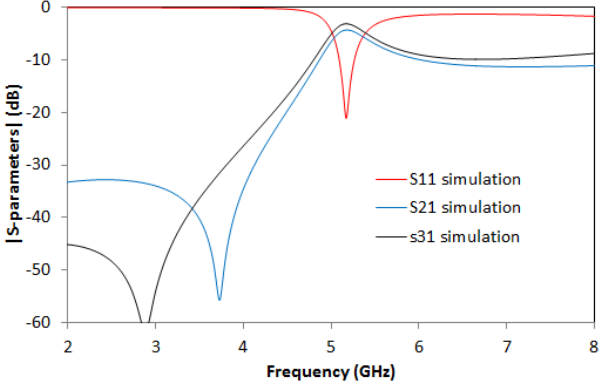
Figure 12. Simulated S21 (solid blue line), simulated S31 (solid black line), and simulated S11 (solid red line).